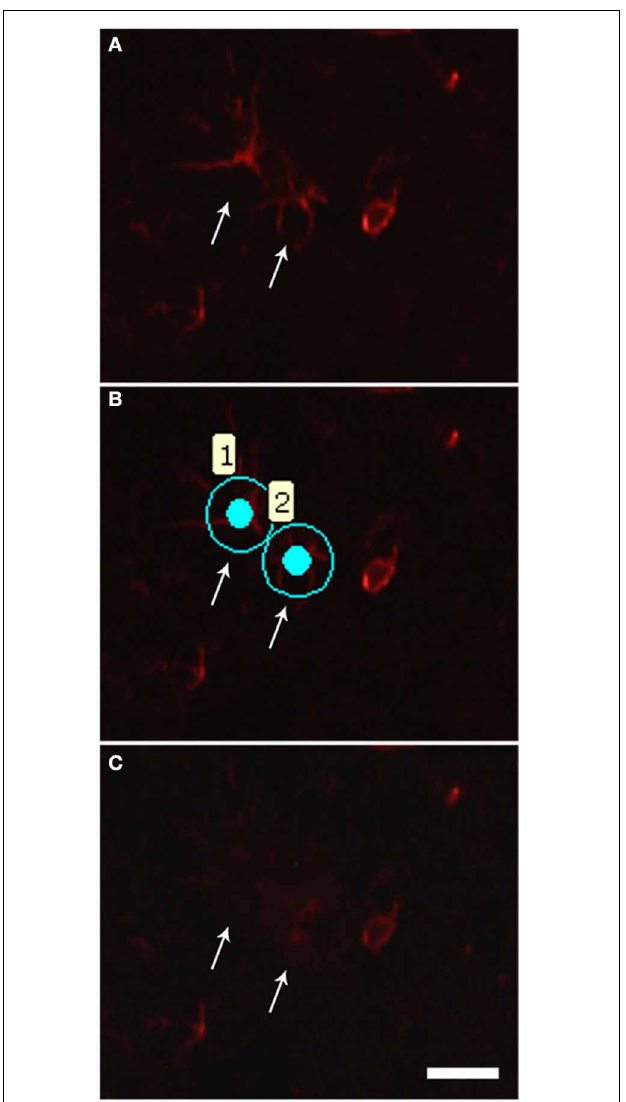
FIGURE 2 | Photomicrographs illustrating astrocyte laser microdissection process. (A) The quick GFAP immunofluorescence allows recognizing the astrocytic profiles (arrows). (B) Astrocytes (1 and 2) were then selected for microdissection. (C) After laser firing and microdissection, selected cells (arrows) can no longer be visualized in the tissue. Scale bars of 20 µ m.